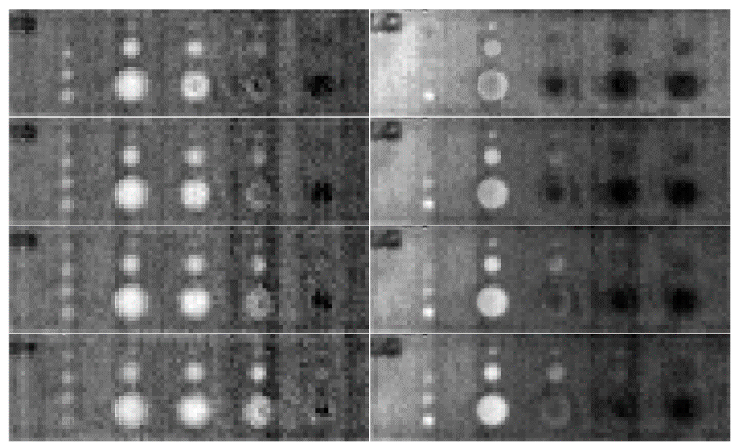
Figure 6. Defect phase contrast obtained by processing every 15th, 18th, 21st and 24th frame (top down): Procedure A left, Procedure B right.